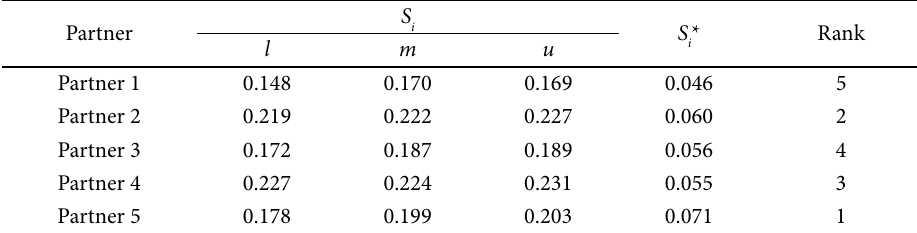
Table 17. The beneficial criteria and the rank of each alternative resulting from the MOORA-F method Partner